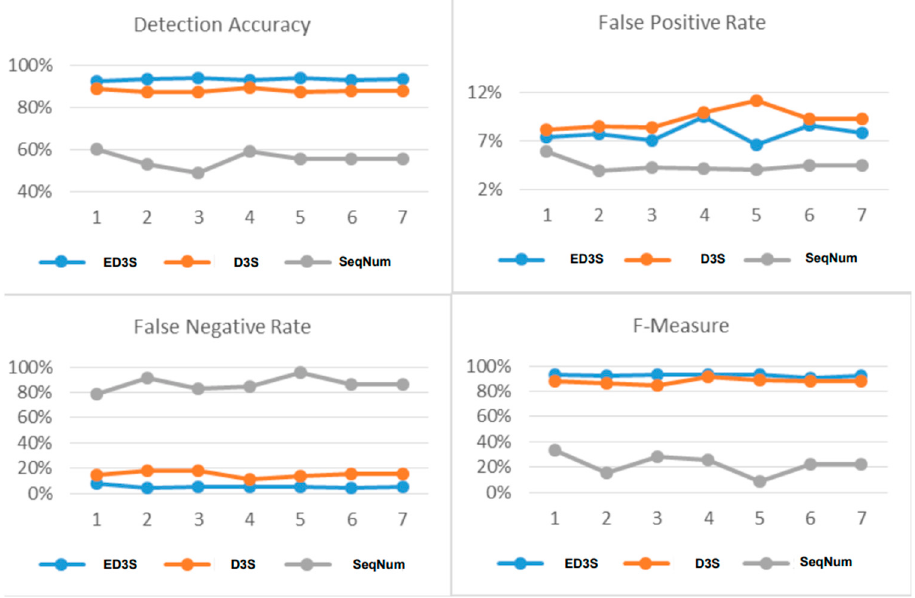
Figure 6. ED3S, D3S, and SeqNum Details Comparison.